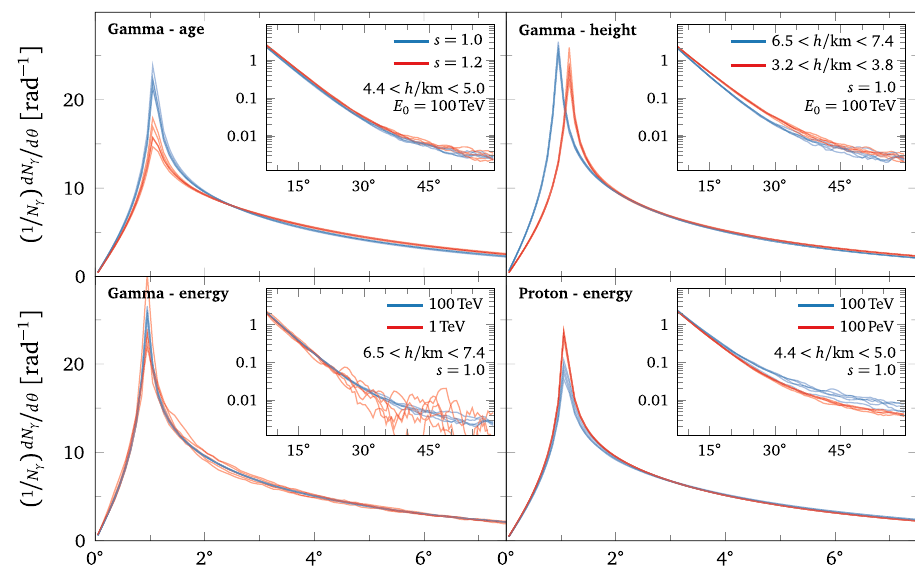
Fig. 3 Examples of simulated angular distributions of Cherenkov photons highlighting its dependency with respect to the shower age (top left), emission height (top right), primary energy in gamma-ray showers (bottom left), and primary energy in proton showers (bottom left)